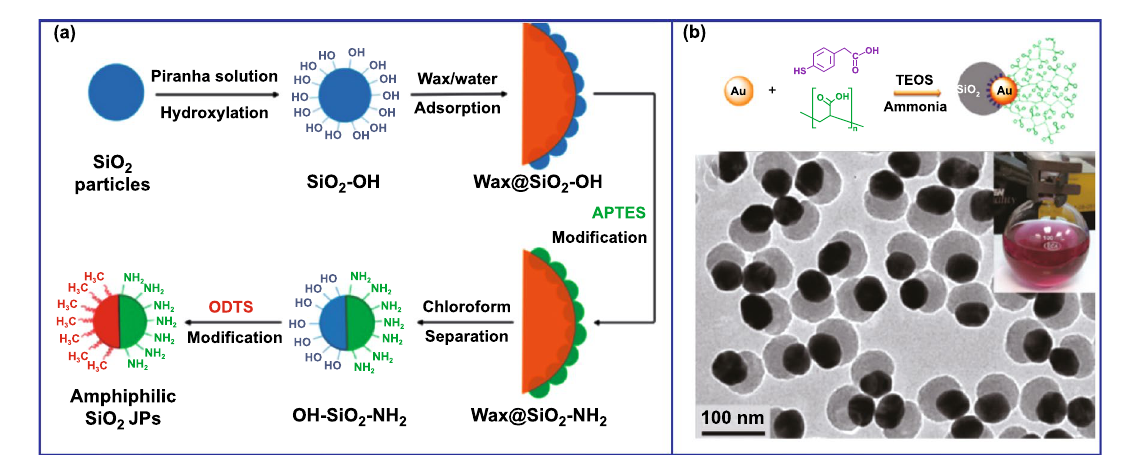
Fig. 8 Preparation of various asymmetric silica-based nanoparticles. a Preparation of amphiphilic Janus silica particles by Pickering emulsion. Reproduced with permission from Ref. [100]. Copyright 2015, American Chemical Society. b Preparation of Janus Au-SiO 2 nanoparticles by selective modification. Reproduced with permission from Ref. [106]. Copyright 2010, American Chemical